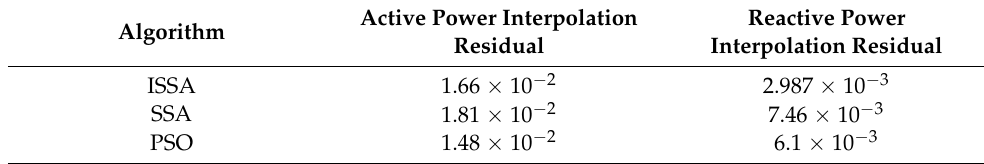
Table 4. Interpolation response residual.